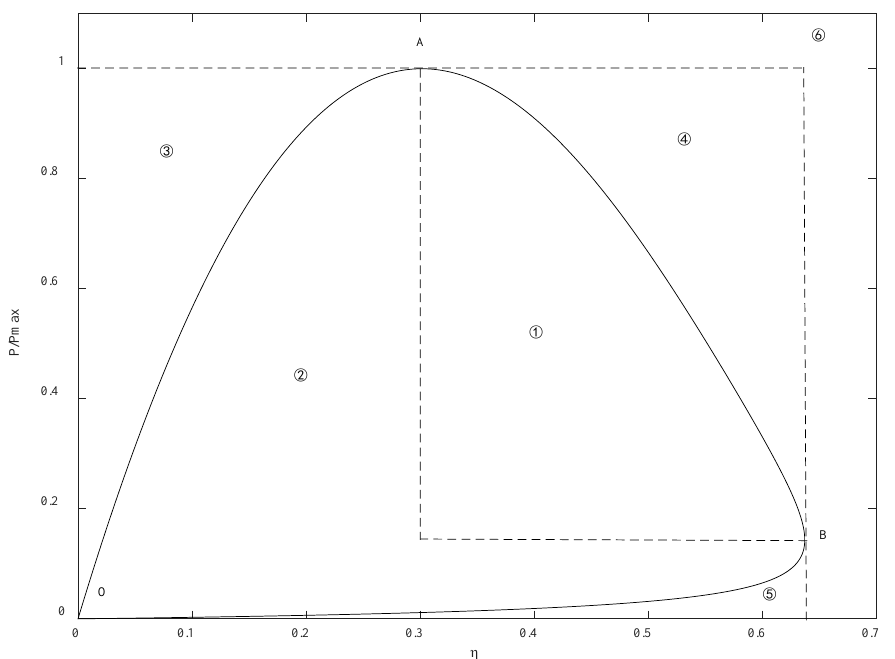
Figure 7. Optimization relationship between P and η . Curve OABO is an optimization curve derived from the power and efficiency